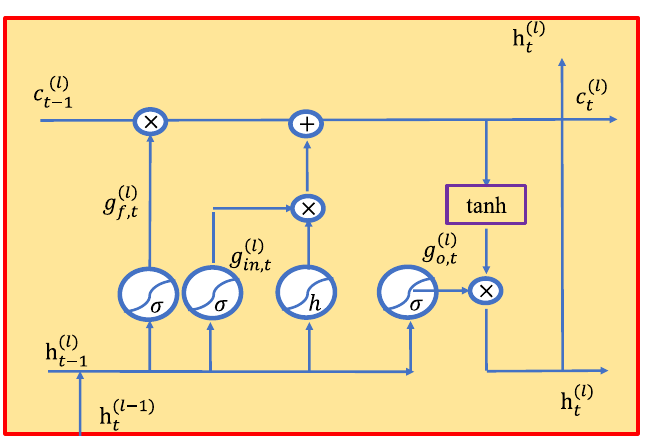
( l ) in , t denotes the input gate; ( l ) t is the output of the l th LSTM layer with a given t th